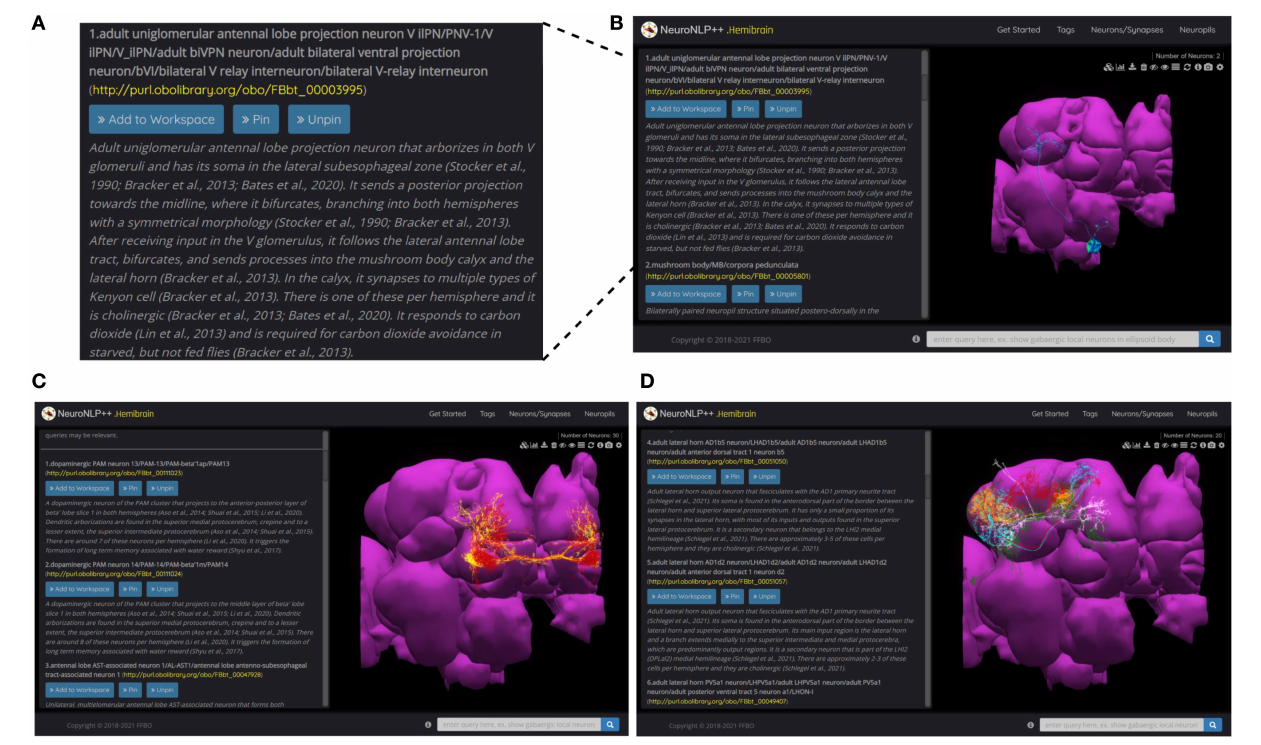
FIGURE 3 | NeuroNLP ++ user interface and query results. (A) Typical results displayed in the Info Panel of the NeuroNLP++ application in response to the query “which neurons respond to carbon dioxide?”. (B) The user interface of NeuroNLP ++ with the Info Panel on the left and 3D visualization workspace on the right. (C) Results to the query “which neurons are associated with water reward?" with the first few relevant entries added to the workspace. (red) PAM13 neurons, (yellow) PAM14 neurons. (D) Results to the query “what cell types are there in lateral horn?” with the first few entries added to the workspace. (red) AD1b5 neurons, (green) LH centrifugal neurons, (cyan) AD1d2 neurons, (orange) PV5a1, (white) PD2a5 neurons.